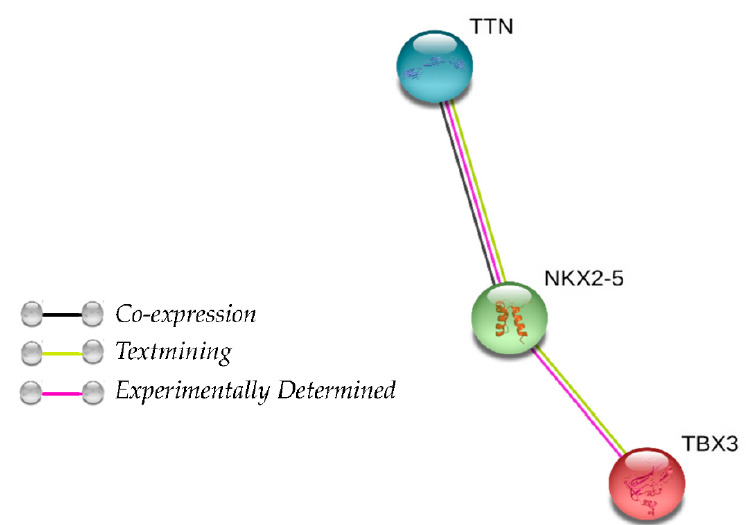
Figure 1. Protein association network in STRING analysis showing interactions of TBX3, NKX2-5, and TTN. Line colors indicate the mode of action of interaction between proteins.